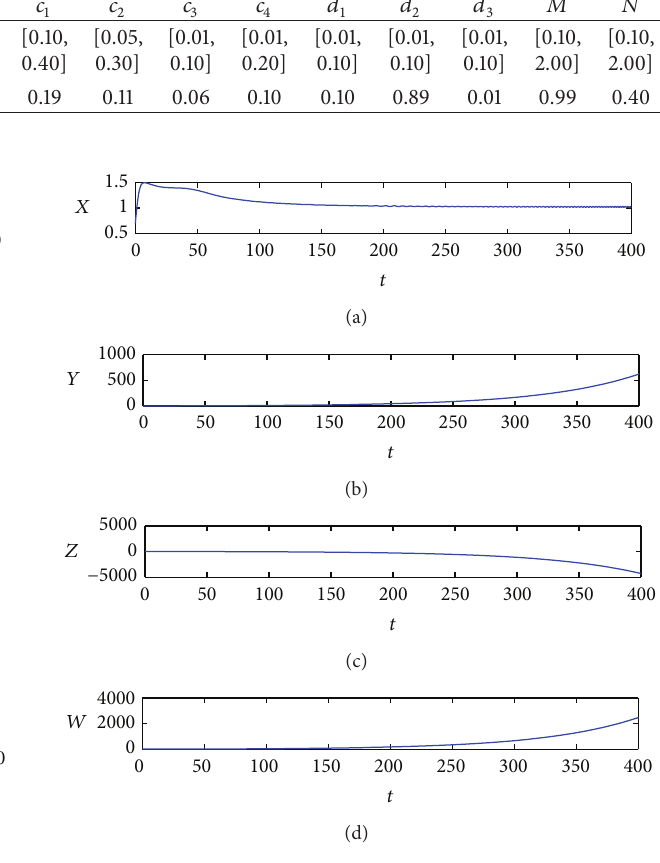
Figure 7: The time series of 𝑋(𝑡),𝑌(𝑡),𝑍(𝑡),𝑊(𝑡) when 𝑀 > 1.5